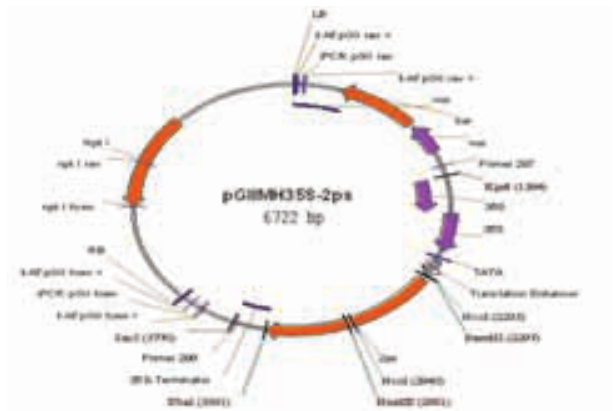
Fig. 1. Map of the pGreen II 35S­ g2PS1 harboring the g2ps1 used in the present